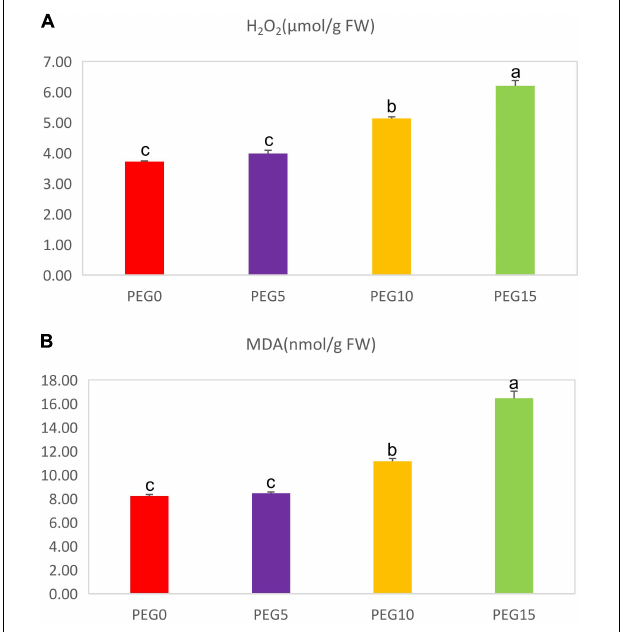
FIGURE 5 | Changes of the malondialdehyde and hydrogen peroxide contents under different drought stress conditions. (A) The content of H 2 O 2 ; (B) the content of malondialdehyde (MDA). Different letters indicate the significant difference at the 0.05 level.